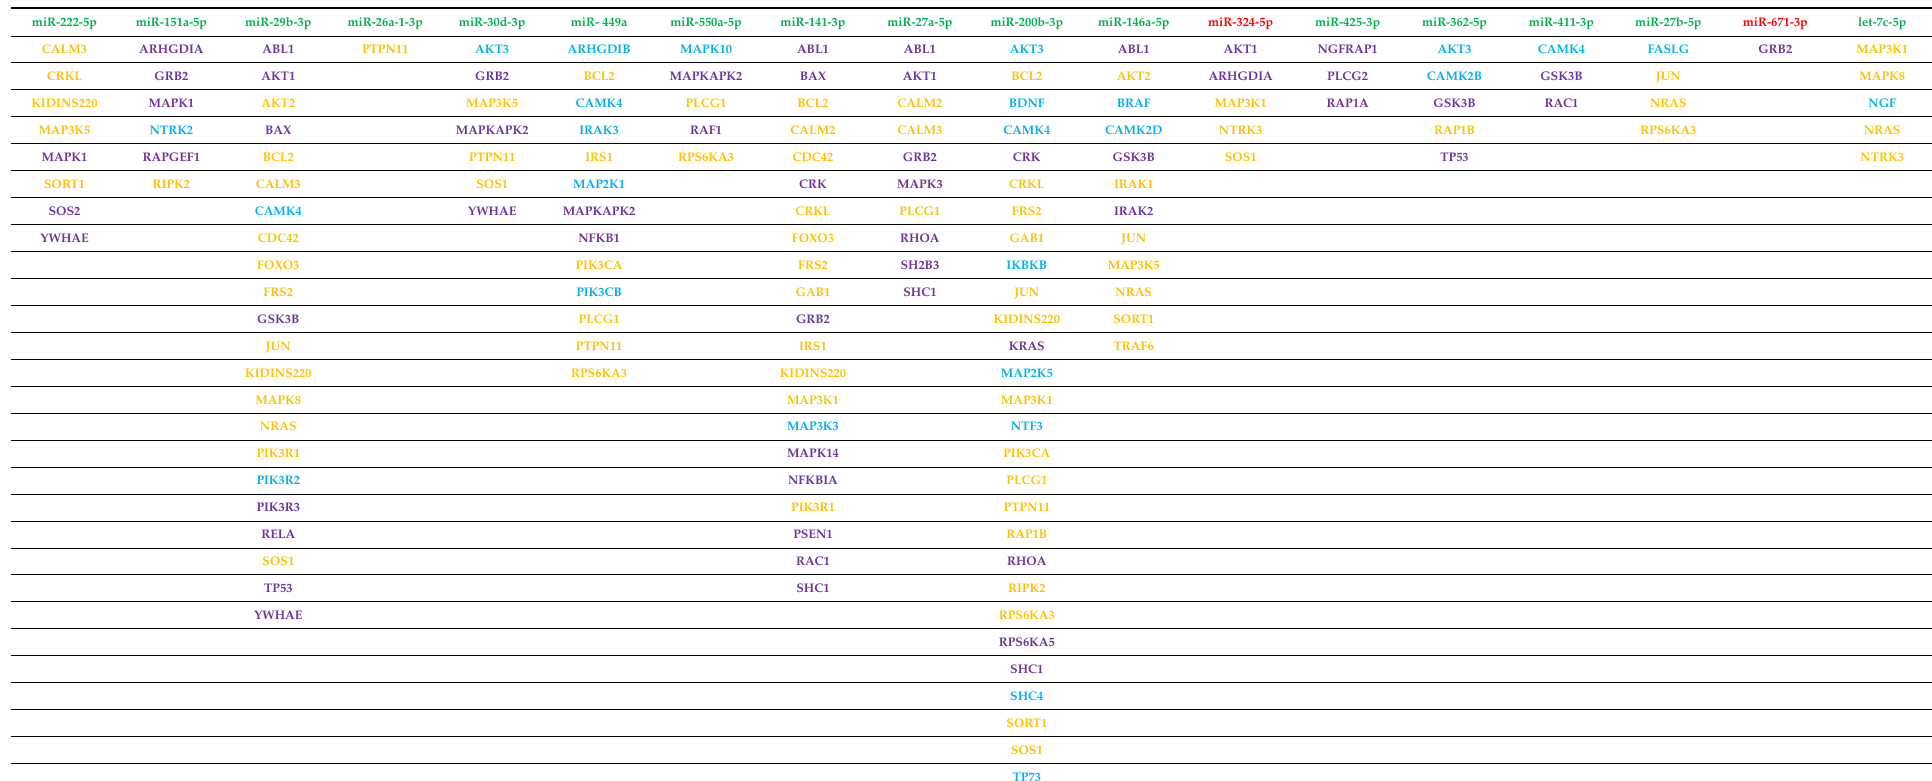
Table 4. MiRNAs and target genes in neurotrophin signaling pathway, as detected by DIANA-TarBase (experimentally supported, in violet), microT (predicted, in light blue), and both (yellow). As shown, several genes were detected by both algorithms. MiRs displaying global down- or upregulation after NGF treatment are represented in green and red,